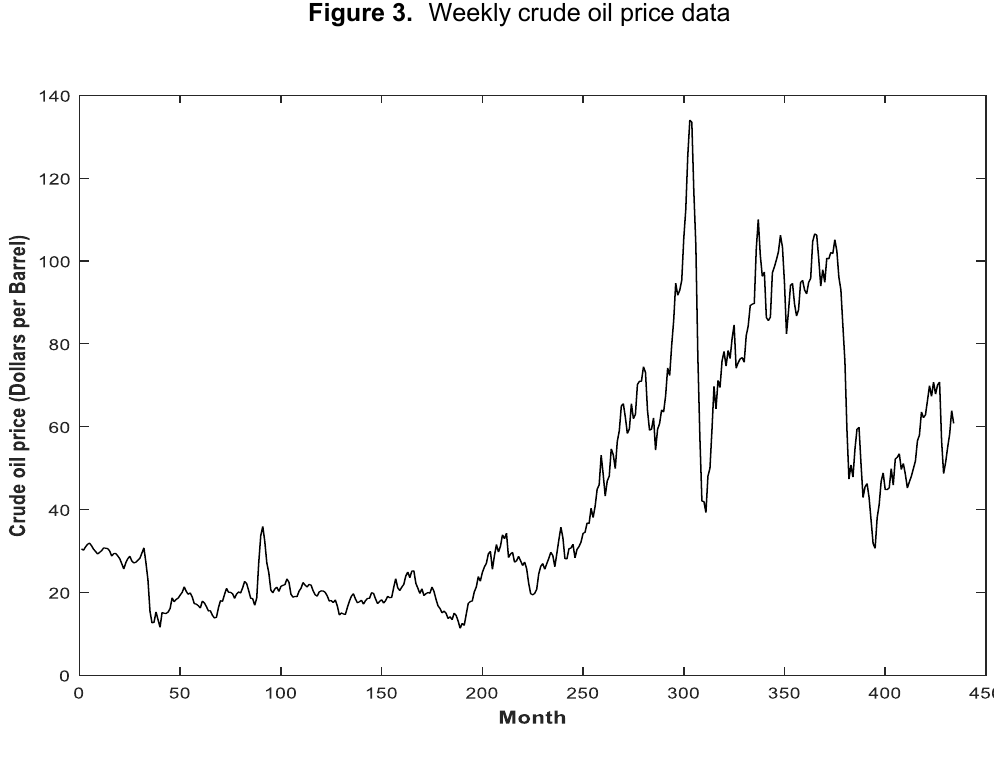
Figure 4. Monthly crude oil price